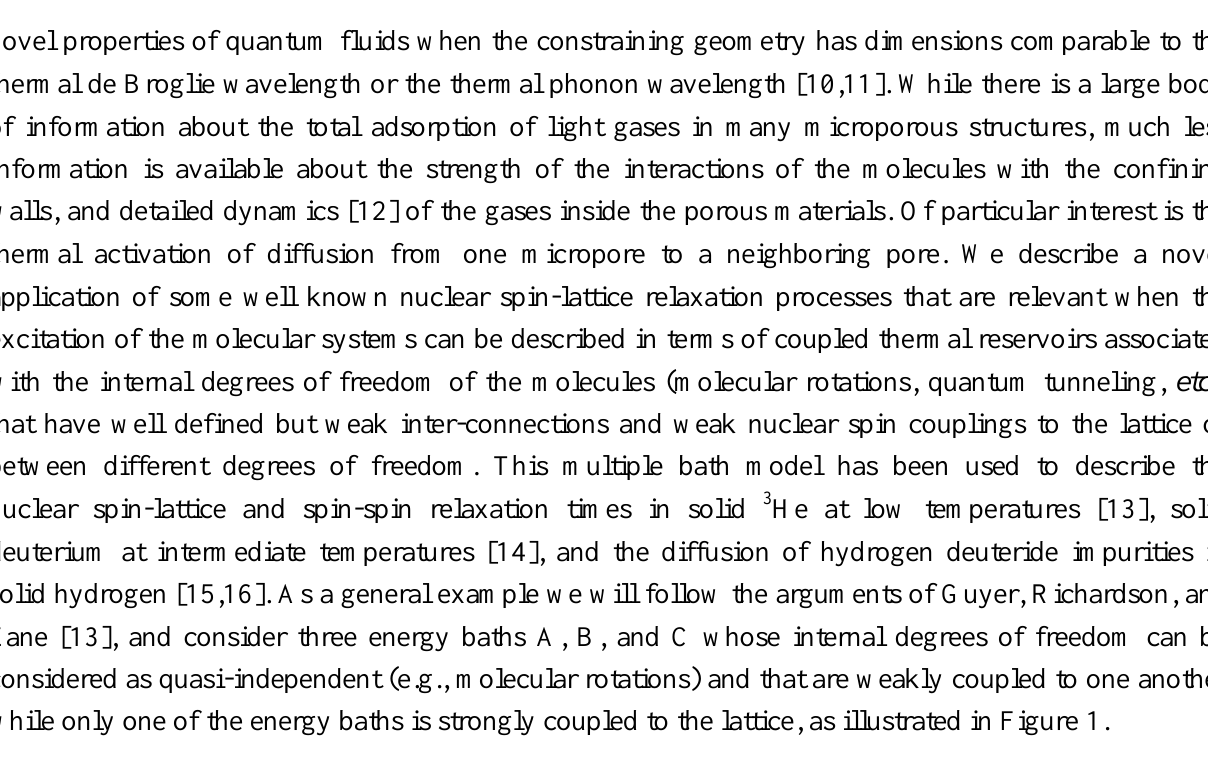
Figure 1. Schematic representation of three energy baths A, B, and C with a weak link (bottleneck) between B and C with energy flow from C to the thermal bath. In this example, there is a bottleneck in the vertical path R BC